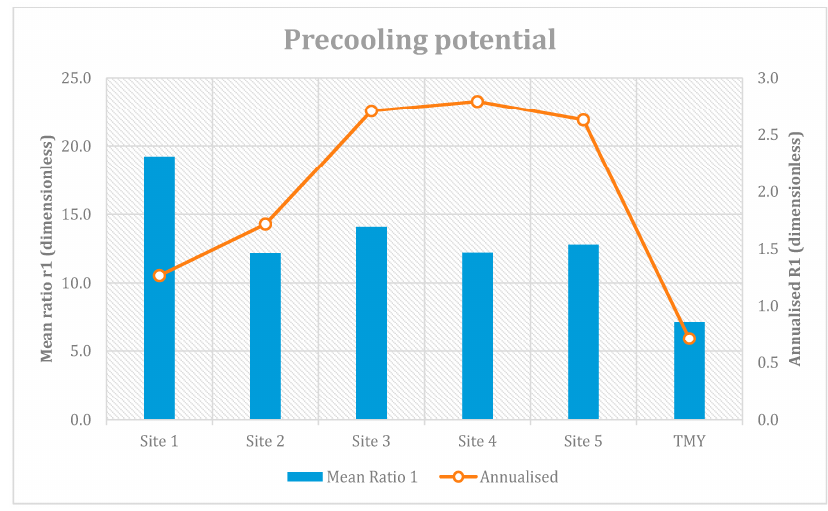
Figure 5. Summary of precooling potential across sites in Sydney.